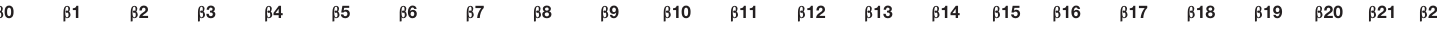
TABLE 2 | Associations between endocrine markers and fitness variables, and accumulated workload training.